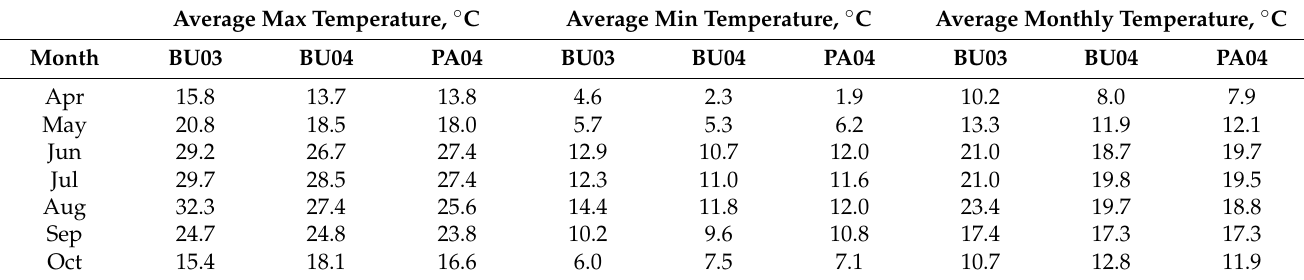
Table 4. Means of monthly maximum and minimum temperatures and monthly average temperatures for each